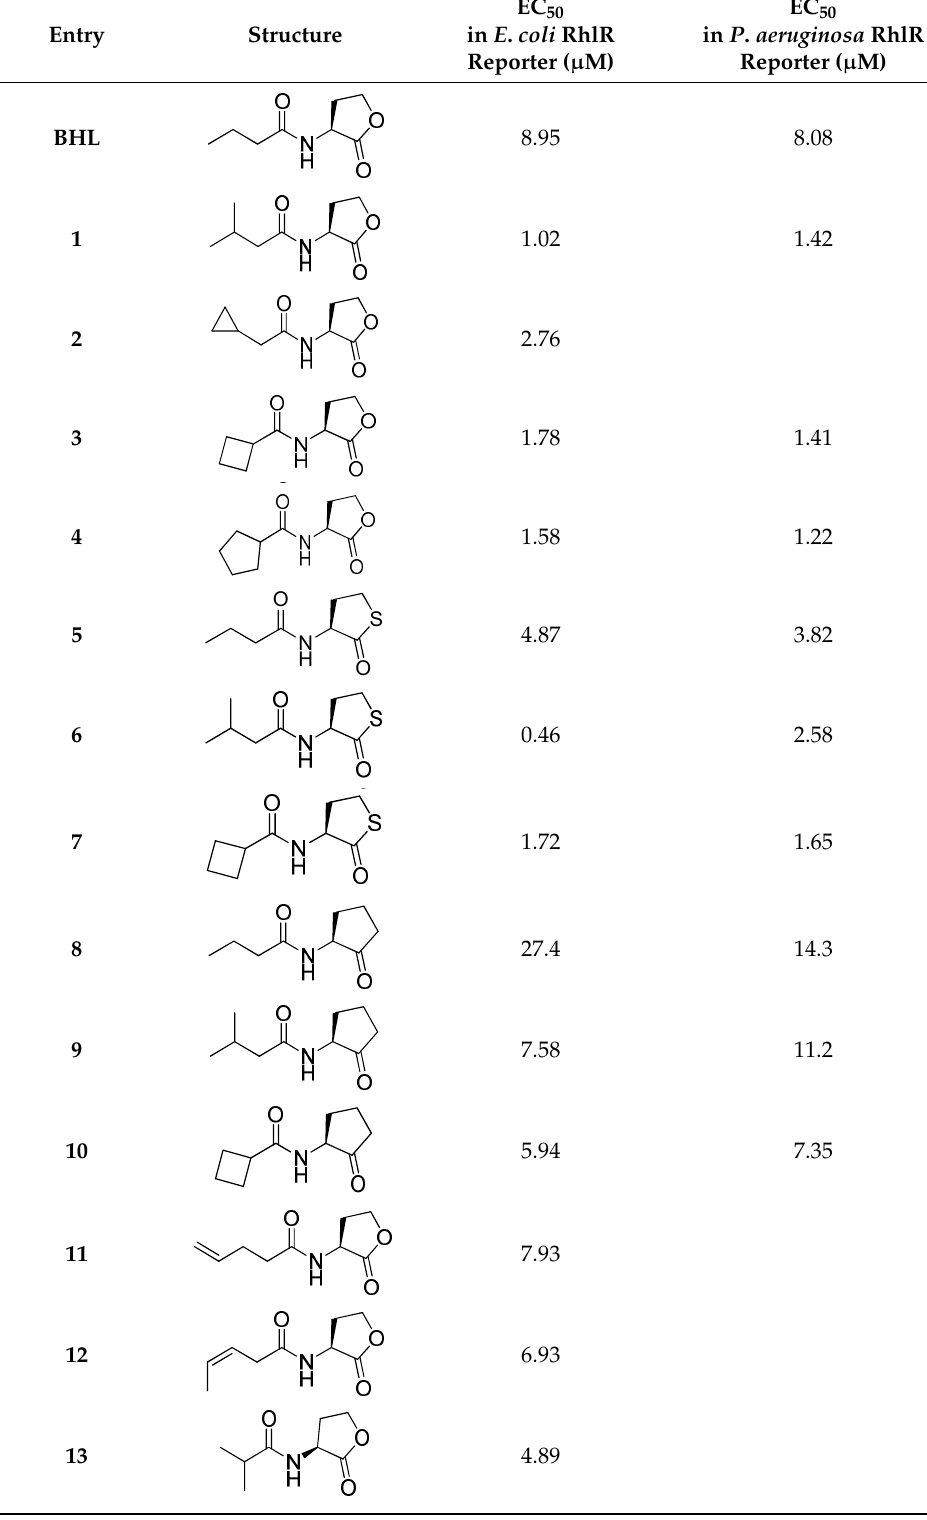
Table 1. RhlR-targeted agonists based on BHL.